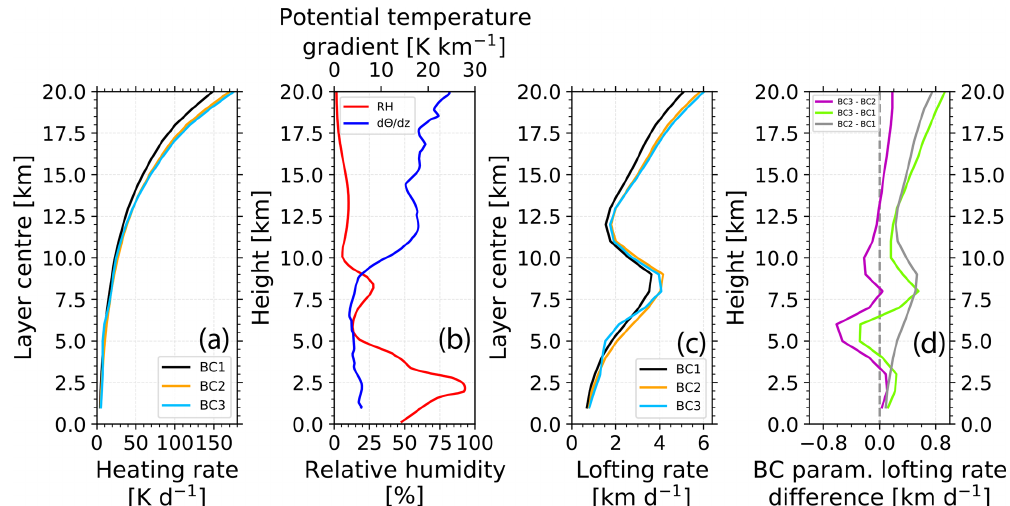
Figure 8. ECRAD self-lofting simulation ( a : heating rate; c : self-lofting rate) of an ascending 2km thick smoke layer (AOT = 1.5 at 532nm, Punta Arenas, 26 January 2020) for three different BC parameterizations shown in Fig. 4. The relative humidity in (b) influences the BC parameterization. In (d) , differences between lofting rate solutions by considering two of the three BC parameterizations (BC1, BC2, BC3) are shown. The simulated daily average heating and lofting rates are given for the layer center height.